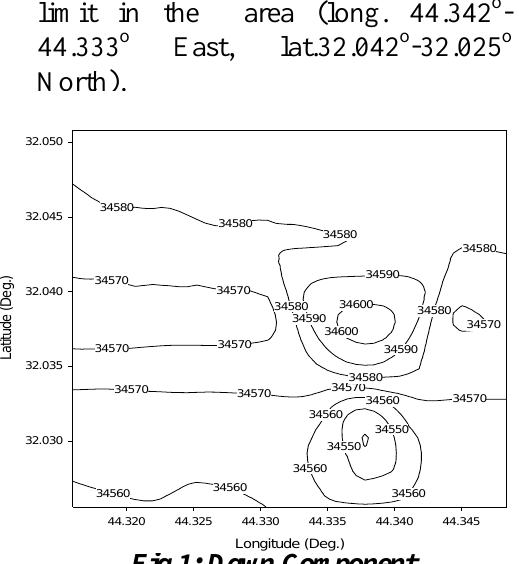
Fig.1: Dawn Component.